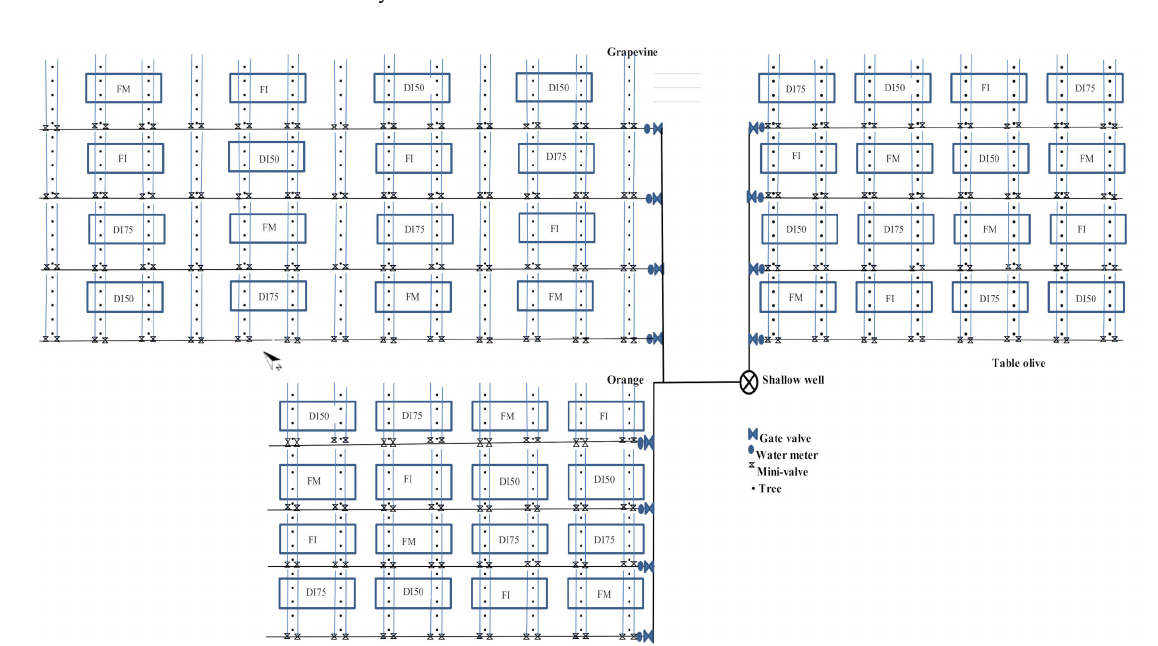
Figure 1. Experiment